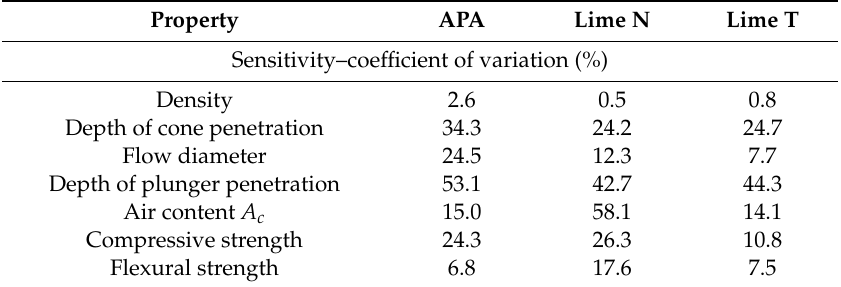
Table 15. The sensitivity of plaster properties to mistakes in dosing water.